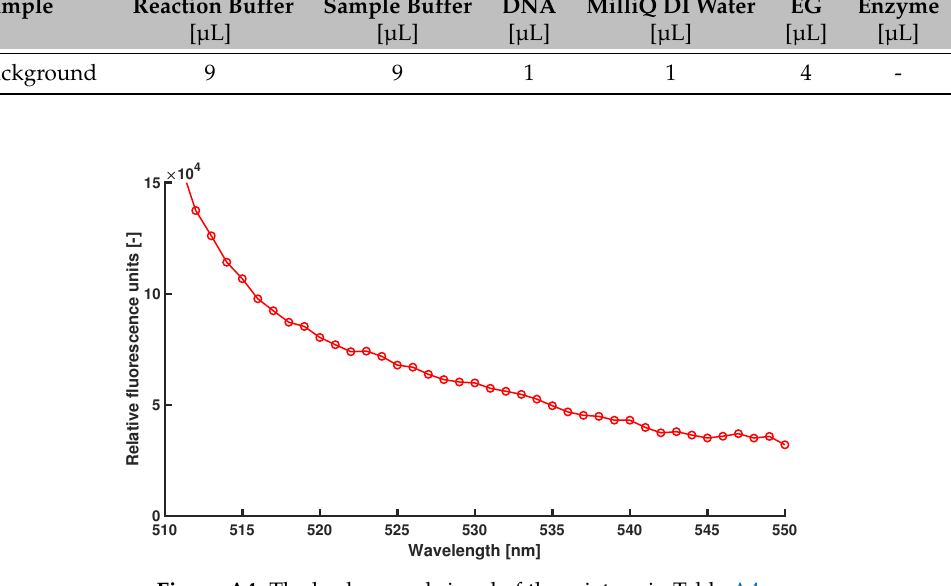
Figure A4. The background signal of the mixture in Table